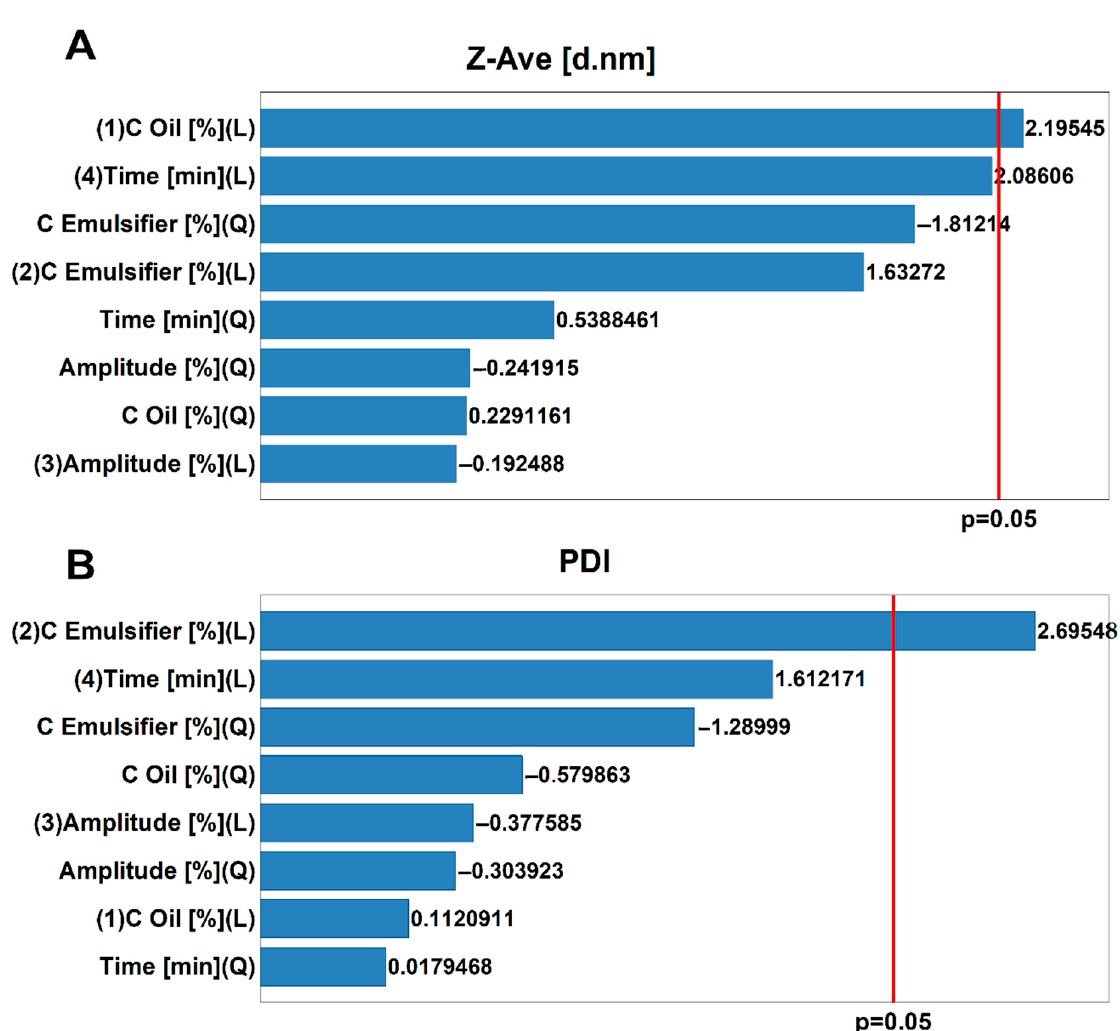
Figure 1. Pareto charts for the influence of input parameters (oil concentration, emulsifier con- centration amplitude, sonification time) on ( A ) average droplet size of nanoemulsions (d. nm), ( B ) polydispersity Index